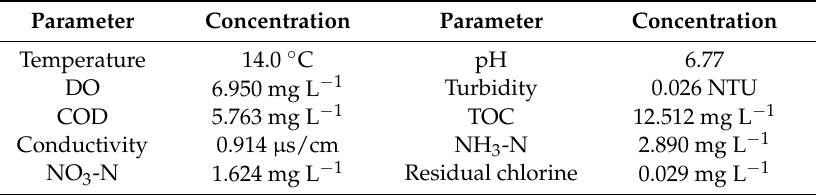
Table 1. Characterization of drinking water in current